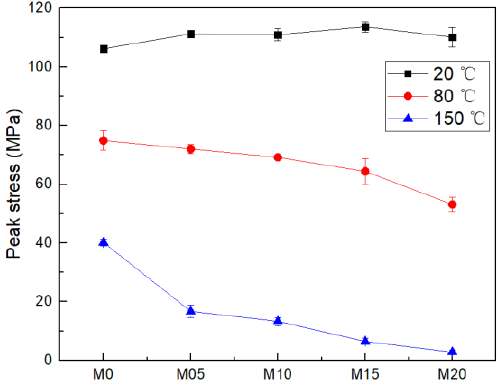
Figure 6. Peak stress of phenolic modified epoxy.